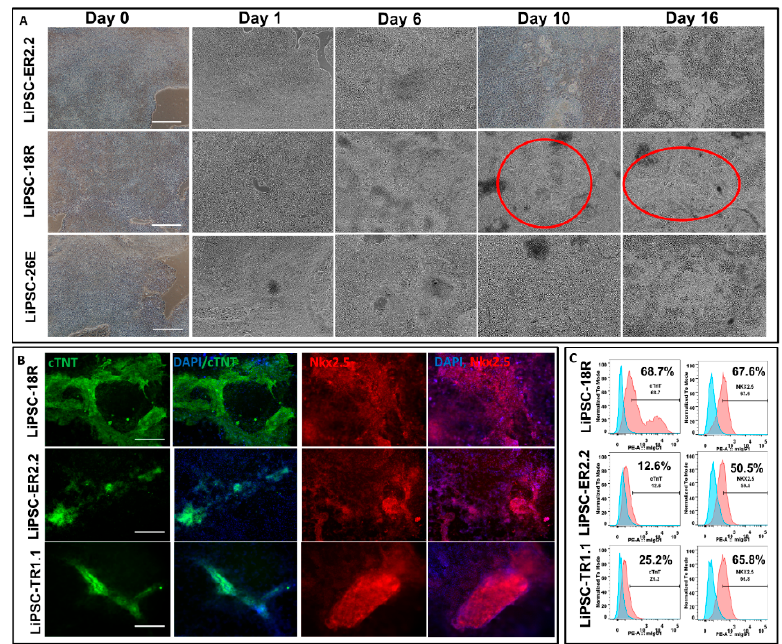
Figure 4. All three current good manufacturing procedure (cGMP)-compliant LiPSCs lines differentiated into cardiomyocytes (CMs) in two-dimensional (2D) culture system. ( A ) Starting with good quality cells (around 100% confluency with very low differentiated areas), three LiPSC lines started morphological changes from day 1 onward until day 14. The first beating was observed for two lines (LiPSC-18R and Er2.2) around day 6–7 within several patches. A large beating area was shown for LiPSC-18R on day 10 and 14 (red circles). ( B ) All of the beating areas on day 14 of differentiation were positively stained for cardiac-specific troponin (cTnT) and Nkx2.5 markers for three LiPSC lines. ( C ) Three LiPSC lines showed positive population expressing NKX2.5 and cTnT. LiPSC-18R showed the highest population expressing NKX2.5 and cTnT among the three. Scale bars, 100 µm.